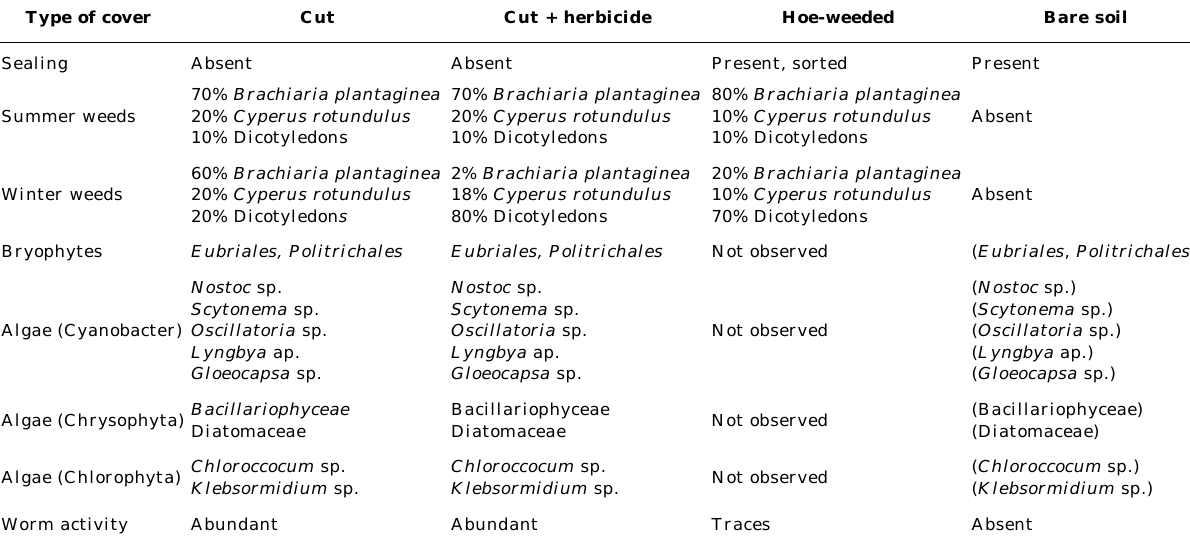
Table 5. Main biologic factors studied as related to differing types of weed management (covers). Names between brackets indicate the presence of very few individuals on the experimental